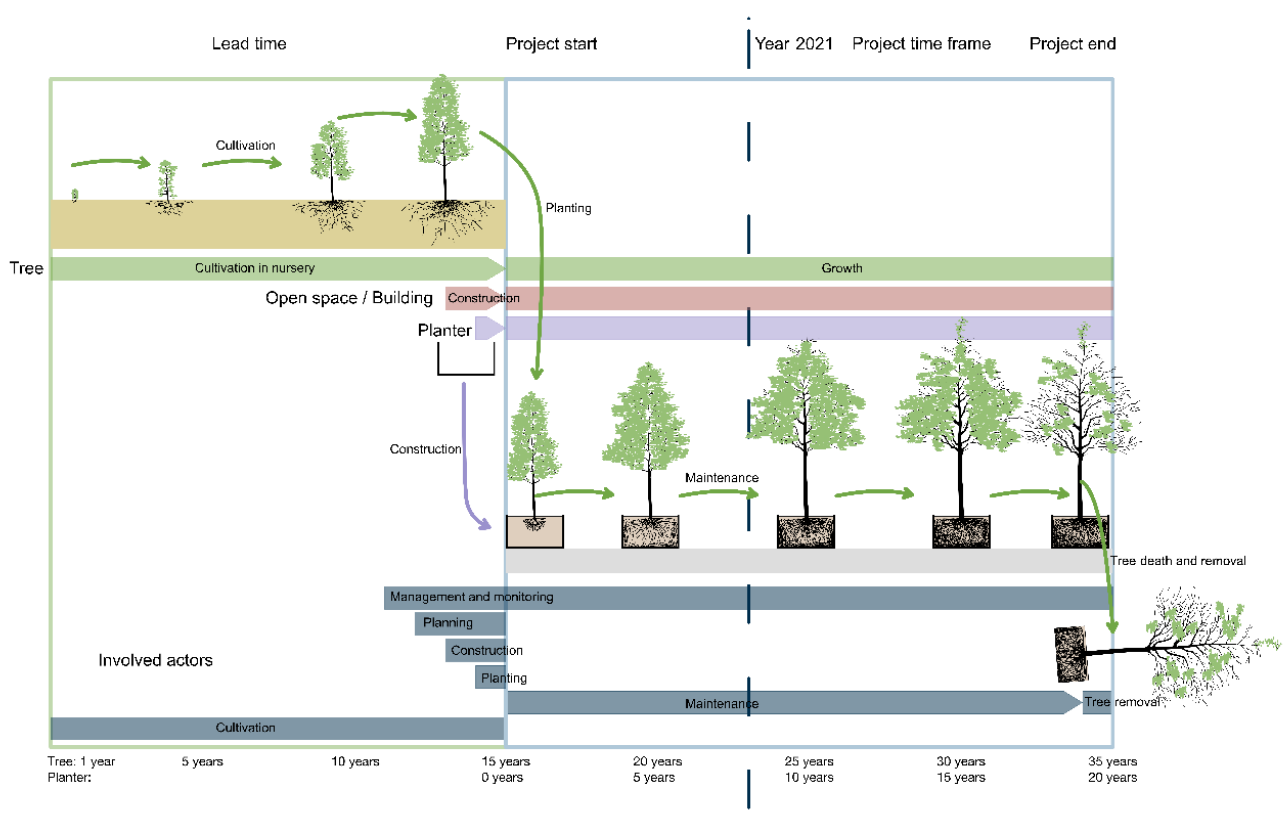
Figure 1. Exemplary representation of the graphical elements of the time diagrams. The temporal aspects are presented in the form of bars. The pointed end of a bar indicates the transition from one process section to the next. The blunt end of a bar indicates the end of the process in the project for the element shown. The temporal aspects of the tree(s) are represented by green bars and include the growing in the nursery, the growth in the planter and the transplantation of the tree or, if applicable, the death of the tree. In case of tree replacement, the temporal aspects of the next tree generation is